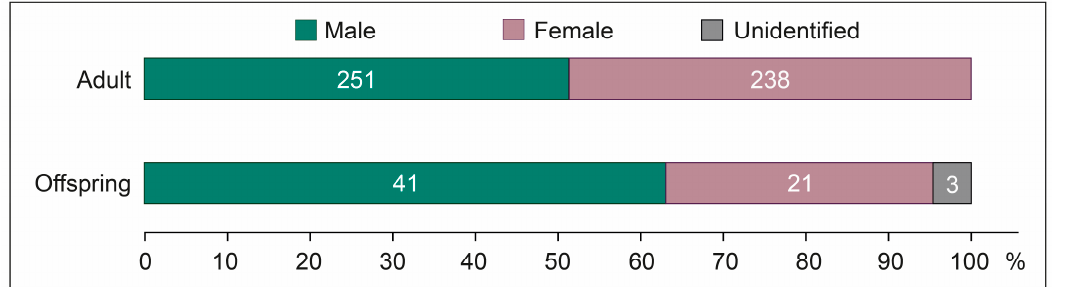
Figure 7. Number of independent captures of Bare-faced Curassow ( Crax fasciolata ) (based on a 30